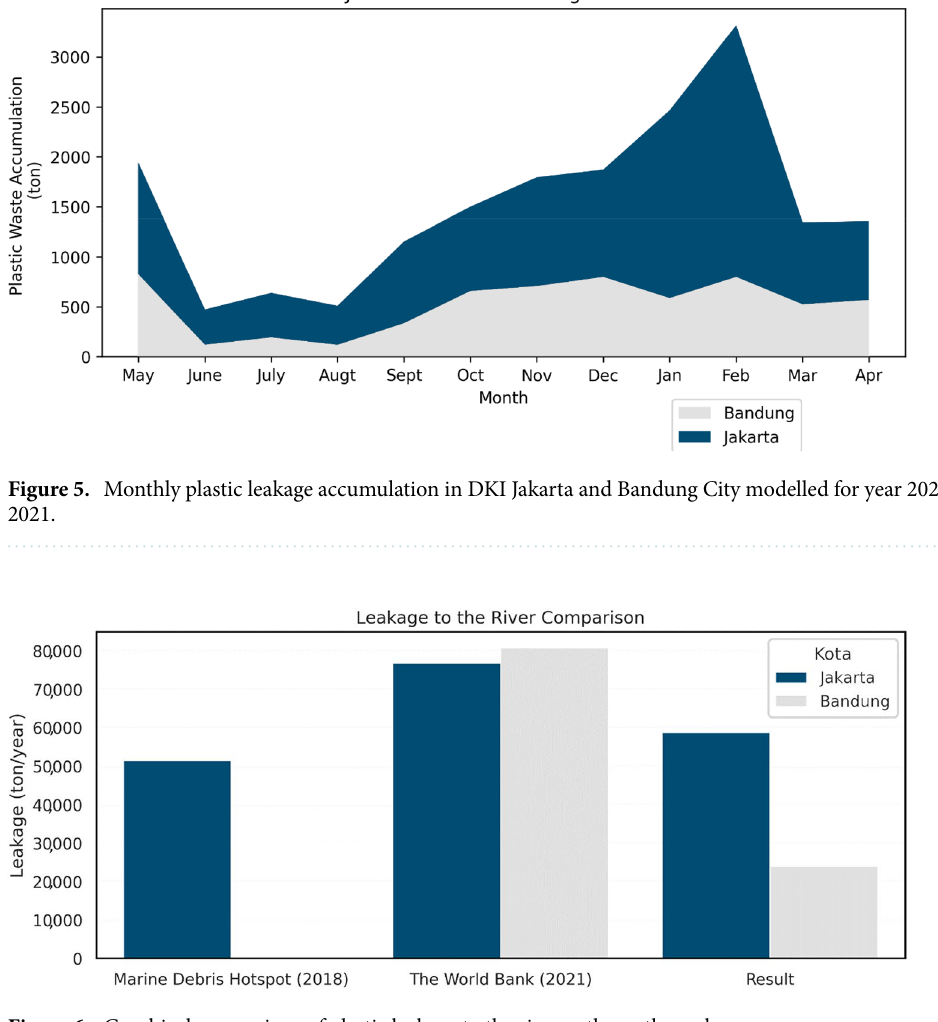
Figure 6. Graphical comparison of plastic leakage to the river pathway through